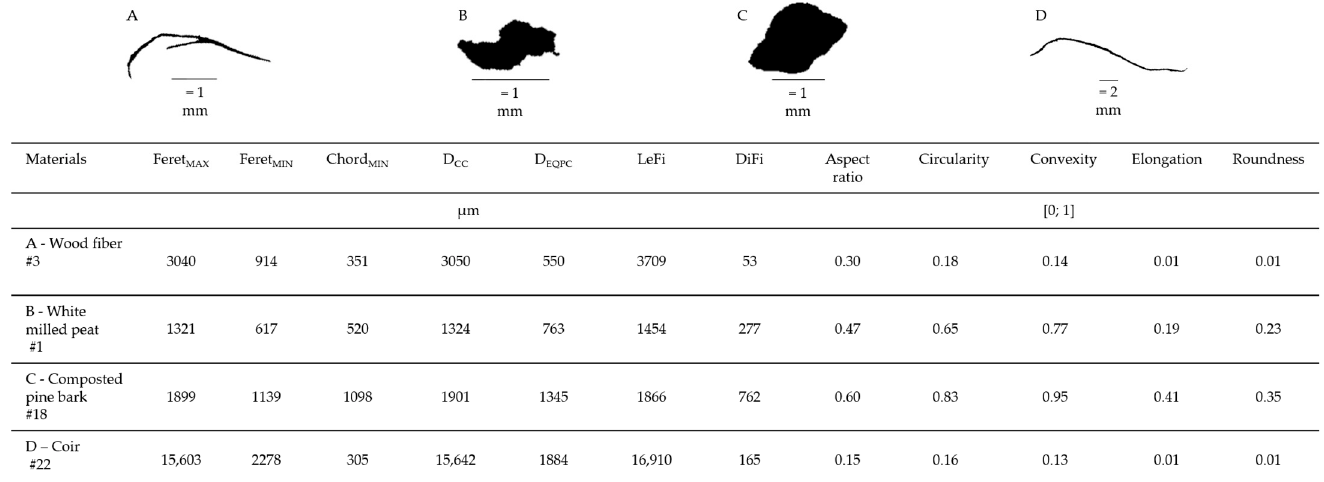
Figure 3. Examples of particles of different materials (Wood fiber medium #3, Irish white peat #5, Composted pine bark ‘fine’ #18, and Coir #22) measured with QicPic and associated morphological descriptor values.